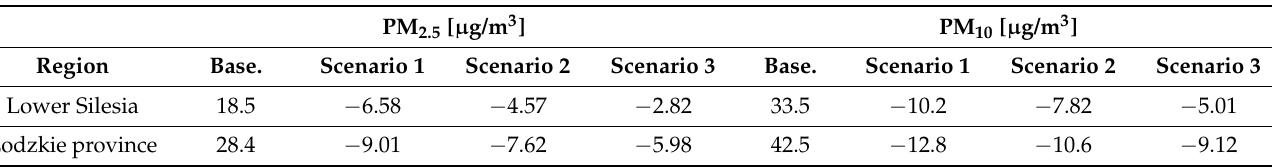
Table 5. Annual air pollution with population weighted concentration reduction with baseline results in Lower Silesia and Lodzkie region. PM 2.5 [ µ g/m 3 ] PM 10 [ µ g/m 3 ] Region